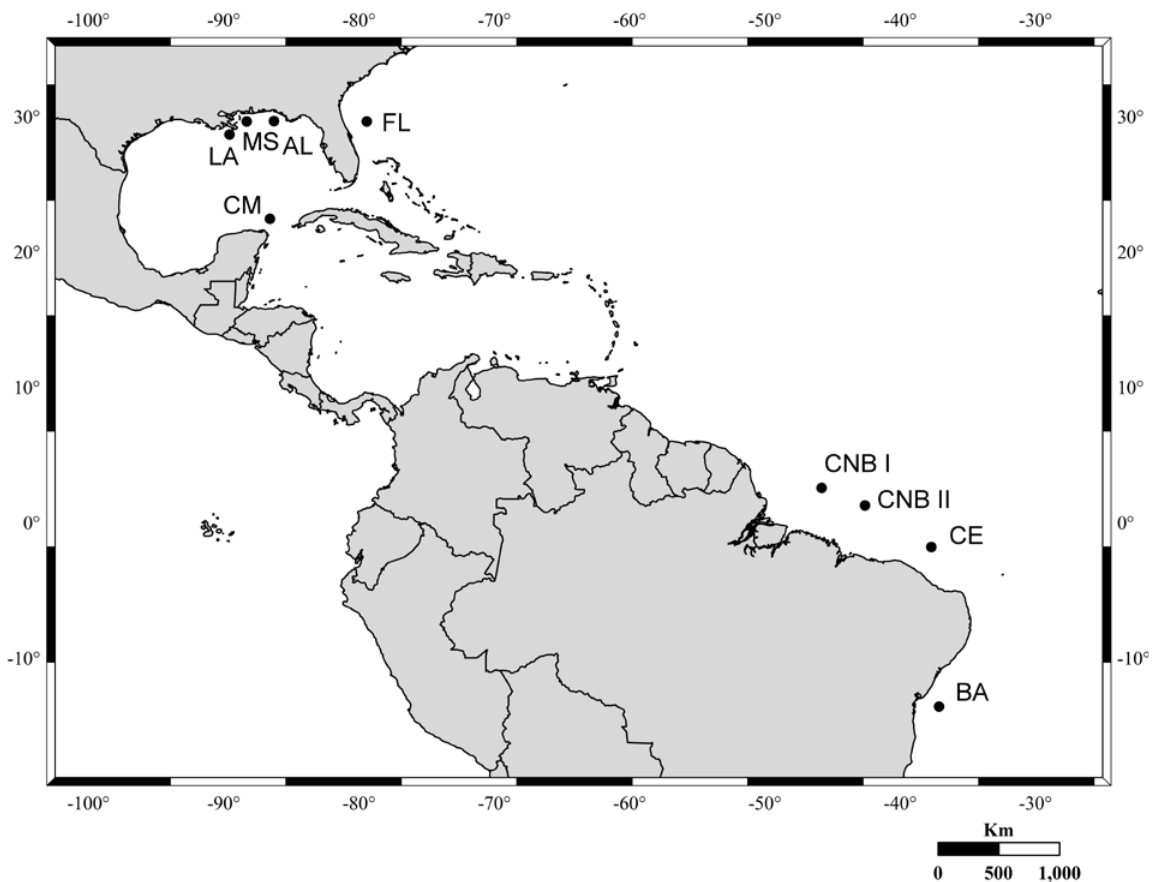
Fig. 1 - Locations of the areas in which the specimens of L. purpureus (Brazil) and L. campechanus (United States and Mexico: Garber et al. 2004) were collected. LA: Louisiana; MS: Mississippi; AL: Alabama; FL: Florida; CM: Cancun, México; CNB: northern coast of Brazil (CNB I – Longitudes: 46° and 50° W; CNB II – Longitudes: 43° and 45° W); CE: Ceará; BA: